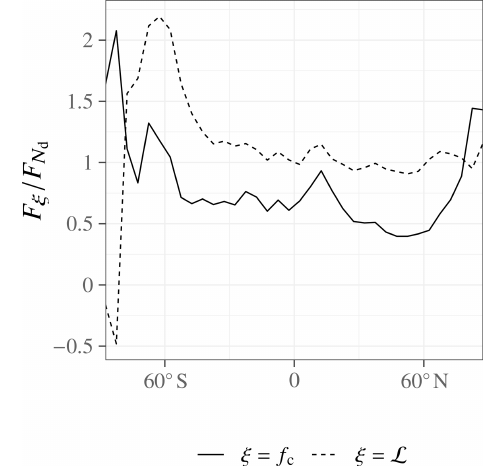
Figure 4. ERF aci adjustments relative to the Twomey